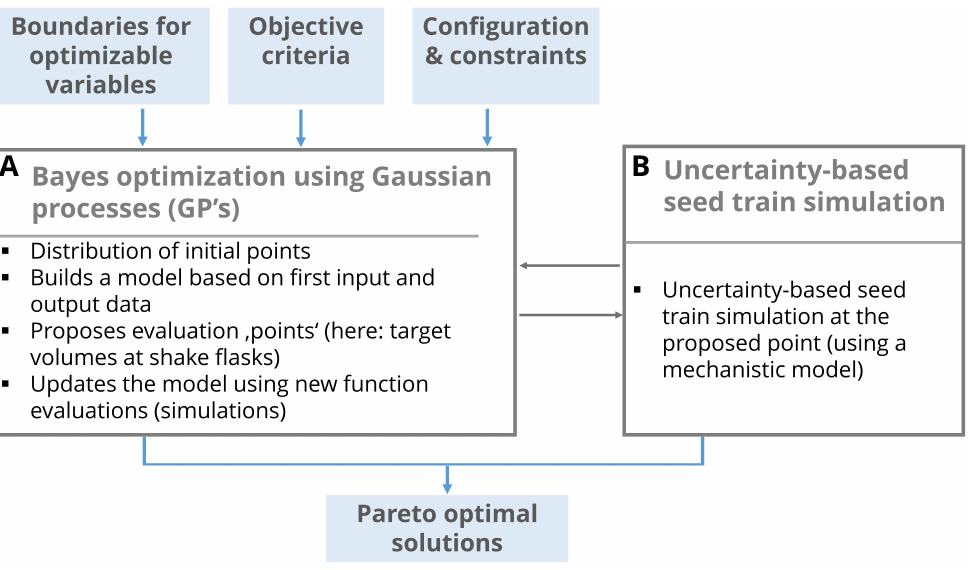
Figure 2. Scheme showing the applied computational workflow comprising: ( A ) a Bayes optimization algorithm which is coupled with ( B ) a seed train simulation routine. Input and output values are shown in the blue boxes above and